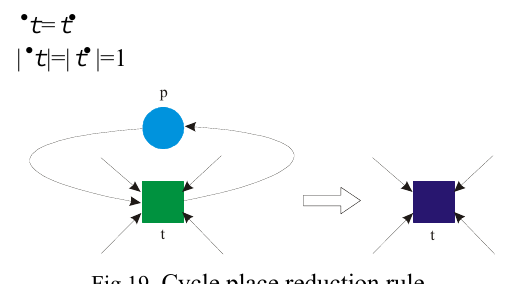
Fig.19. Cycle place reduction rule